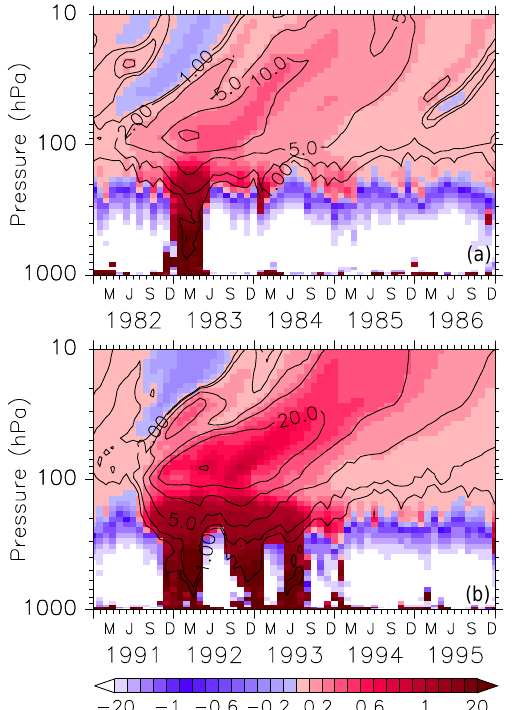
Figure 12. Same as Fig. 6 but for 1000–10hPa with nearly logarith- mic contour intervals from 1 to